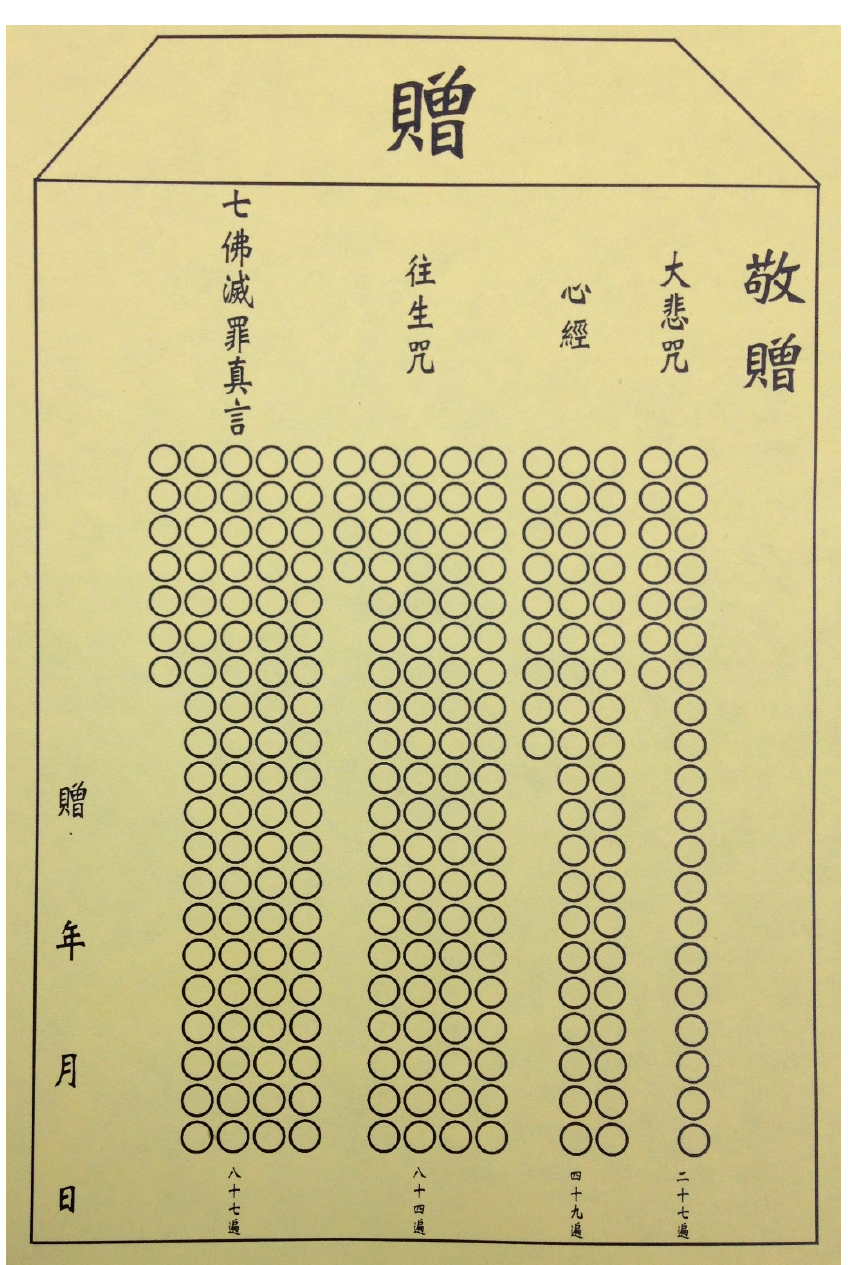
Figure 3. Chanting tally card ( zeng ) from Guanyin Citta Dharma Door (Chinatown, Philadelphia). Source: www.jivaka.net.